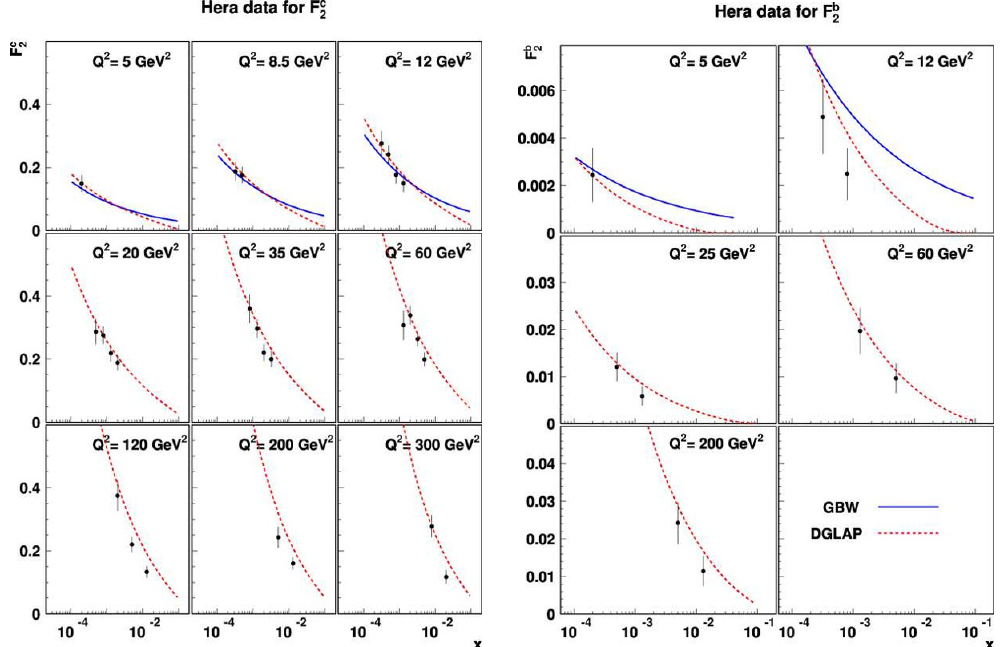
Figure 7 . Comparison of the HERA data from [47] for the charm F c (right panel) structure functions with the results from the GBW model (solid lines) and DGLAP improved model (dashed lines) with the parameters of Fit 2 in table 1 and 3, respectively. The GBW model lines are only shown in the region where the model was fitted and slightly above. Figure 8 . The longitudinal structure function F L in the GBW model (solid line) and DGLAP improved model (dashed line) with the parameters from Fit 2 in table 1 and 3, respectively, against the HERA data from